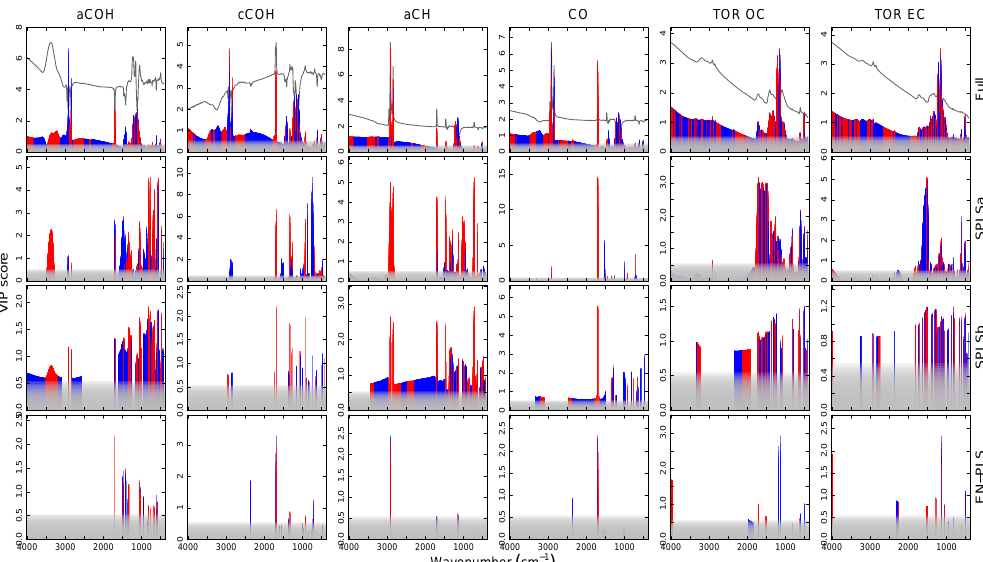
Figure 6. VIP for solutions using raw spectra. Dark gray lines in the “full” solution panels correspond to the first loading weights, and the vertical bars in every panel extend from 0 to VIP scores. Red points accompanying vertical bars indicate wavenumbers for which regression coefficients are positive and blue points indicate wavenumbers for which coefficients are negative. Regions up to VIP scores of 0.5 are shaded to indicate VIP scores not considered for our interpretation (Sect. 3.3).